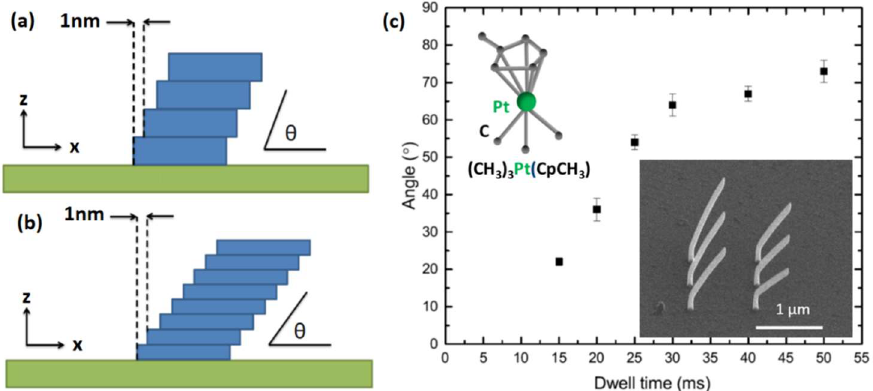
Figure 4. Calibration Experiment. ( a , b ) Deposits resulting after scanning the electron beam with a 1 nm pitch, with long ( a ) versus short ( b ) dwell times. A long dwell time ( a ) results in more electron exposure and higher vertical growth per dwell spot, giving a higher angle θ; ( c ) Angle θ is measured as a function of dwell time for a constant pitch of 1 nm, resulting in a set of calibration points. Insets: Chemical structure of the precursor used and set of nanowires used to obtain the calibration points. For all wires, a small vertical pillar has been grown prior to the segment used for calibration, to facilitate the segment lifting from the substrate.